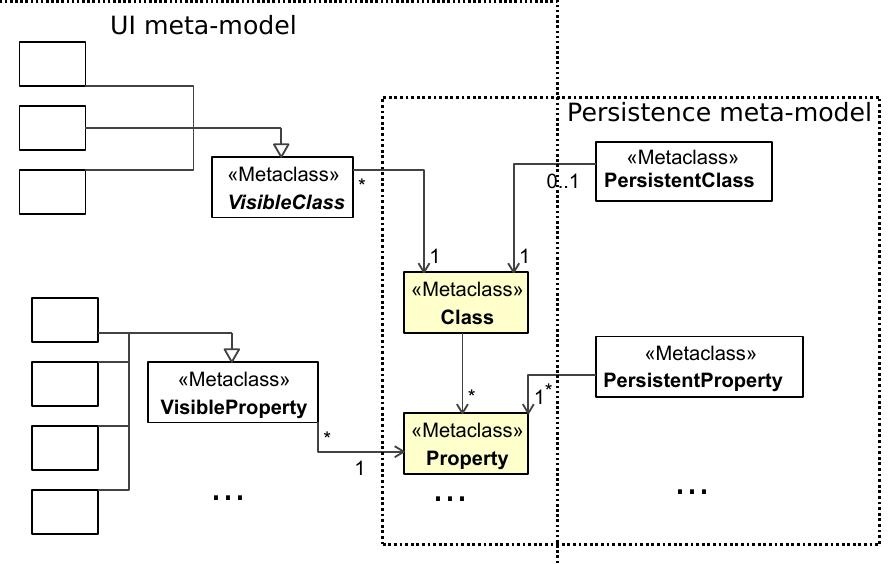
Figure 8. A sketch of UI meta-model and Persistence meta-model integration using common meta- classes from simplified UML::Kernel meta-model